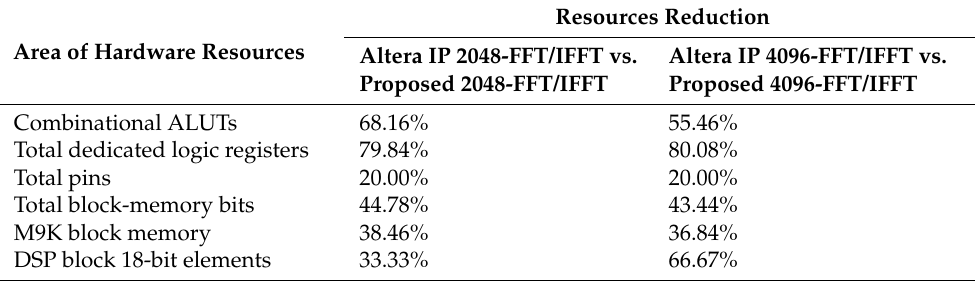
Table 3. Resource reduction of the proposed system (different points of FFT/IFFT, 2048-, and 4096- point) in reference to Altera